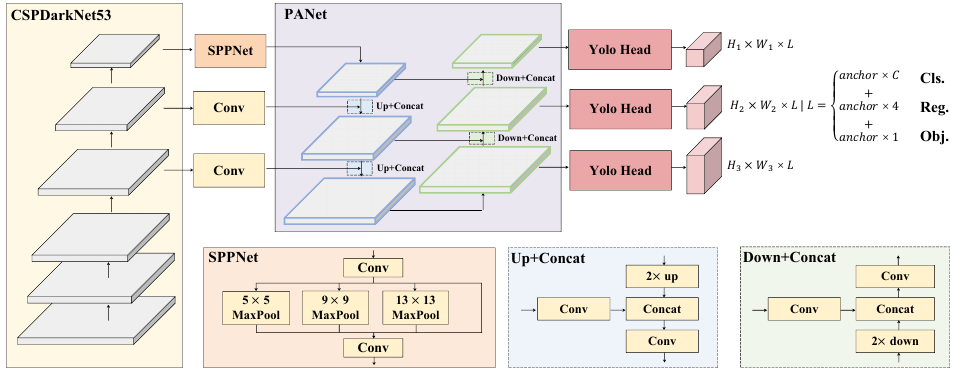
Figure 4. The overall structure of YOLO